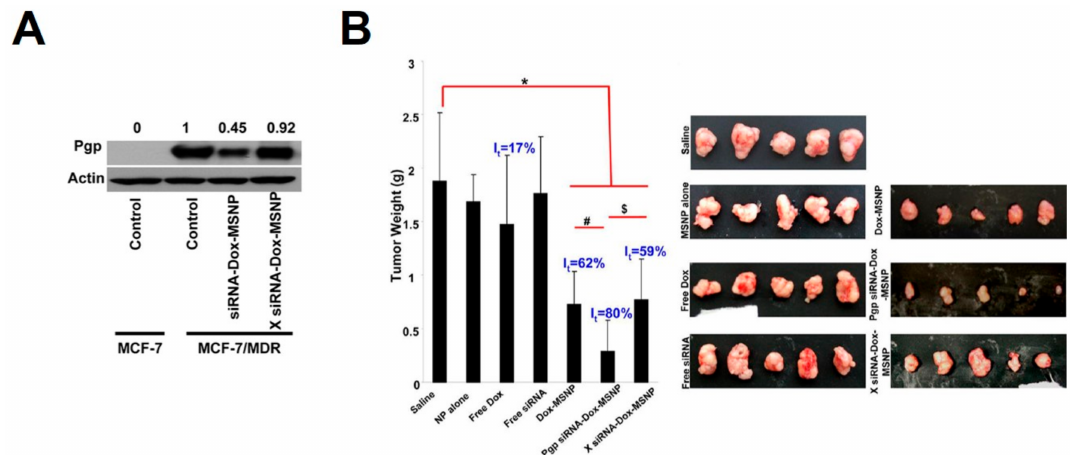
Figure 7. ( A ) Western blotting analysis of Pgp in MCF-7 cells or drug resistant MCF-7 cells